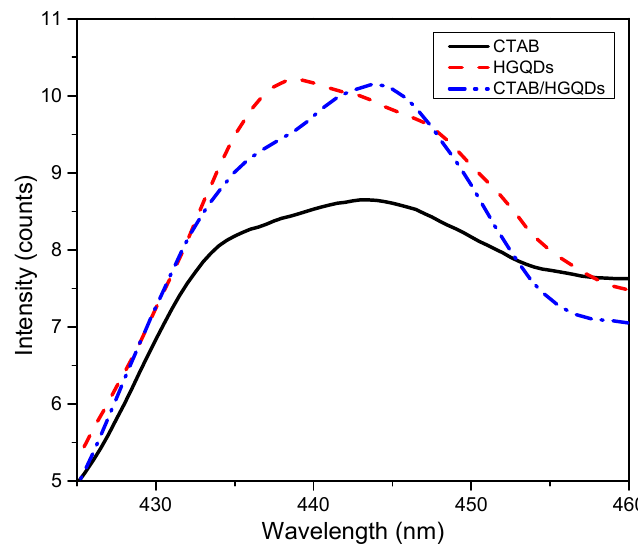
Figure 10. Photoluminescence (PL) spectra of CTAB, HGQDs, and CTAB/HGQDs thin films.